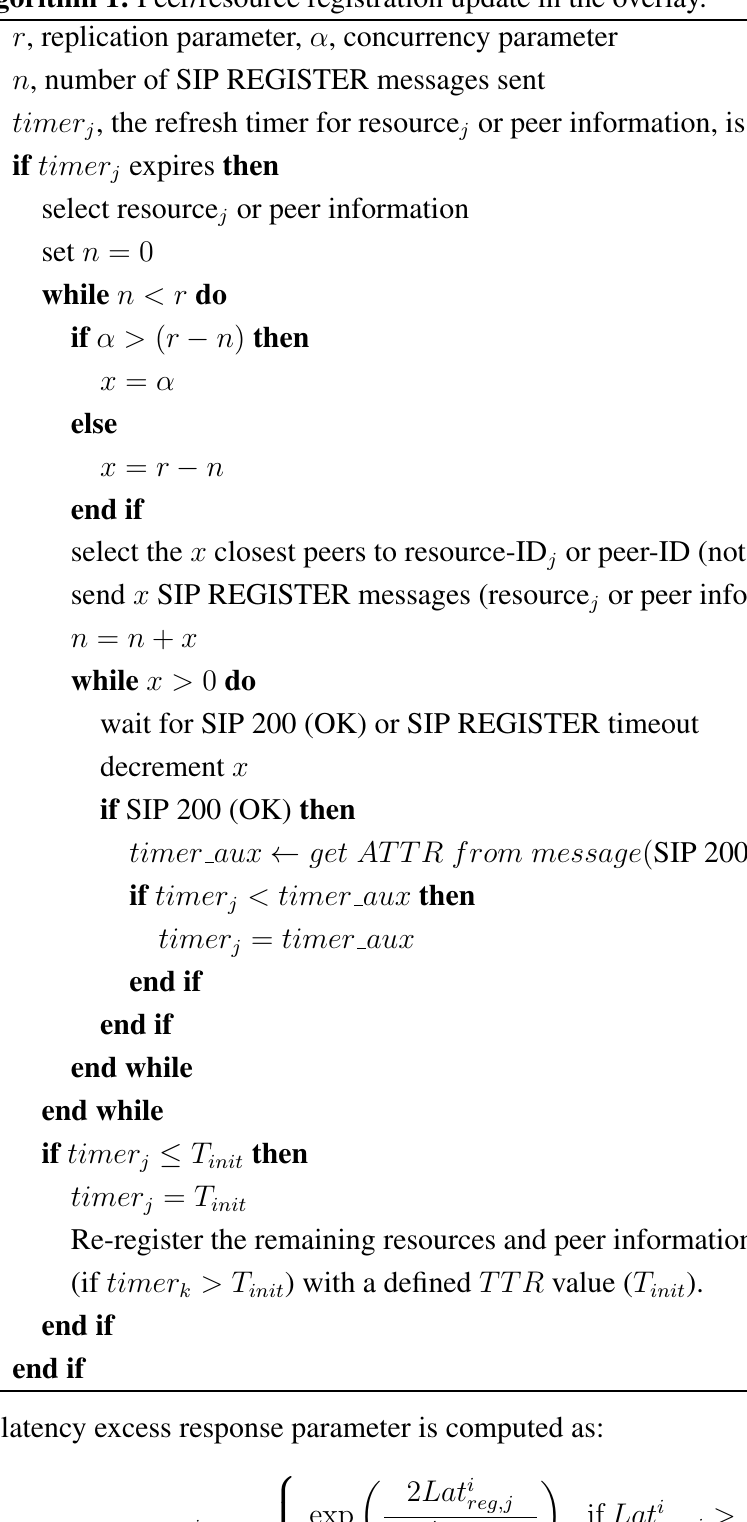
Algorithm 1: Peer/resource registration update in the overlay. r , replication parameter, α , concurrency parameter n , number of SIP REGISTER messages